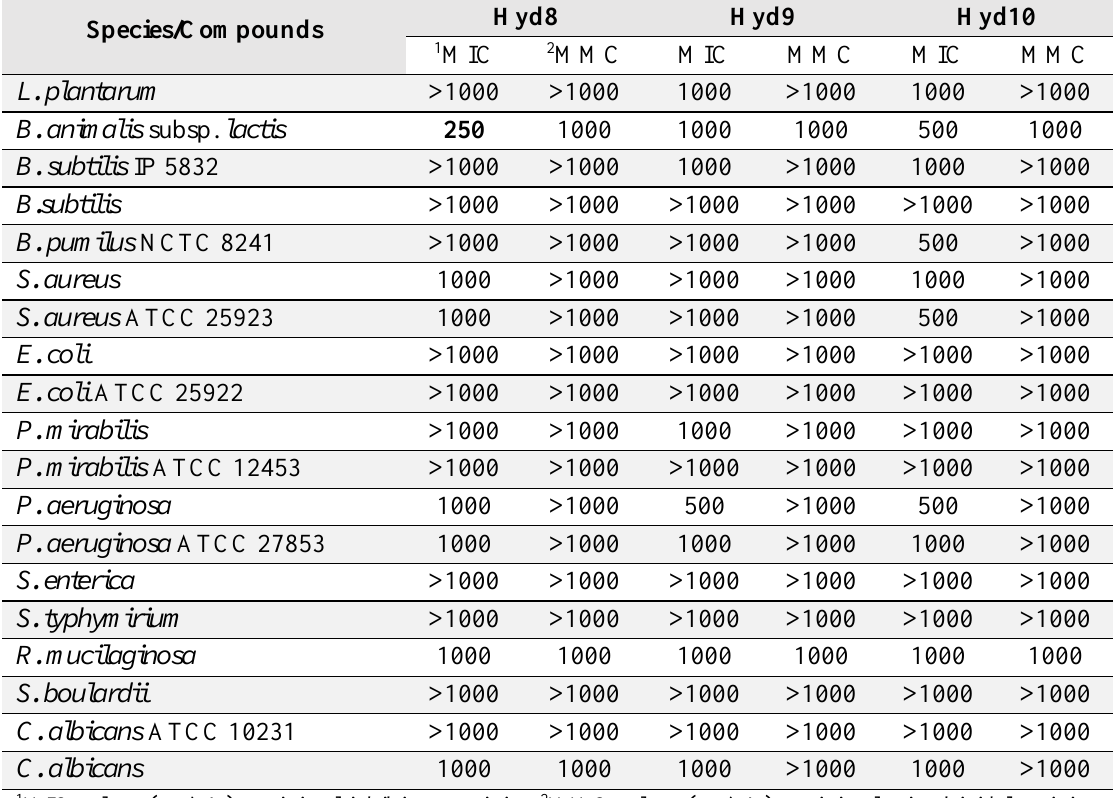
Table 2. Antimicrobial activity of phenyl hydantoin derivatives.